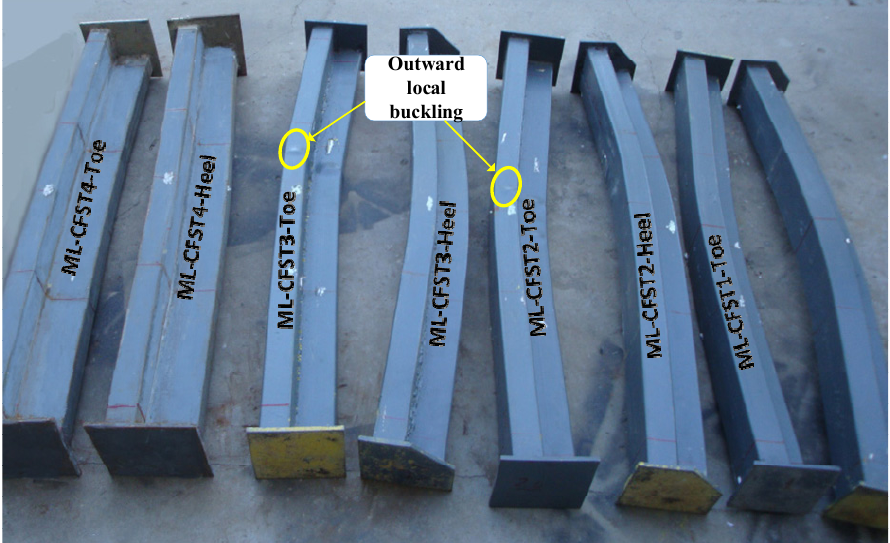
Figure 13. A general view of the ML-CFST specimens after the test.